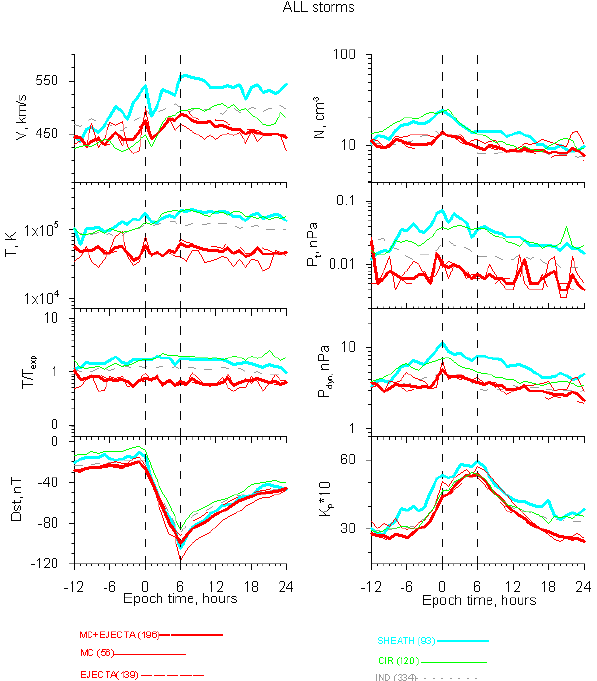
Fig. 1. Behavior of interplanetary parameters and magnetospheric Dst and Kp indices for magnetic storms with Dst < -50 nT gener- ated by different interplanetary drivers: (1) all ICME (MC+Ejecta), (2) MC, (3) Ejecta, (4) Sheath, (5) CIR, and (6) ”Indeterminate” (see designations in bottom of figure) during 1976-2000 on the ba- sis of OMNI database obtained by double superposed epoch analy- sis method with two reference times: onset (”0” time, 1st dashed line) and minimum Dst index (”6” time, 2nd dashed line). Pre- sented parameters: (Left column) V - velocity, T - proton tempera- ture, T/Texp - ratio of measured proton temperature to calculated temperature Texp using average dependence of temperature on ve- locity V (Lopez and Freeman, 1986), Dst index, (Right) n - density, Pt - thermal pressure, Pdyn - dynamic pressure, Kp index.